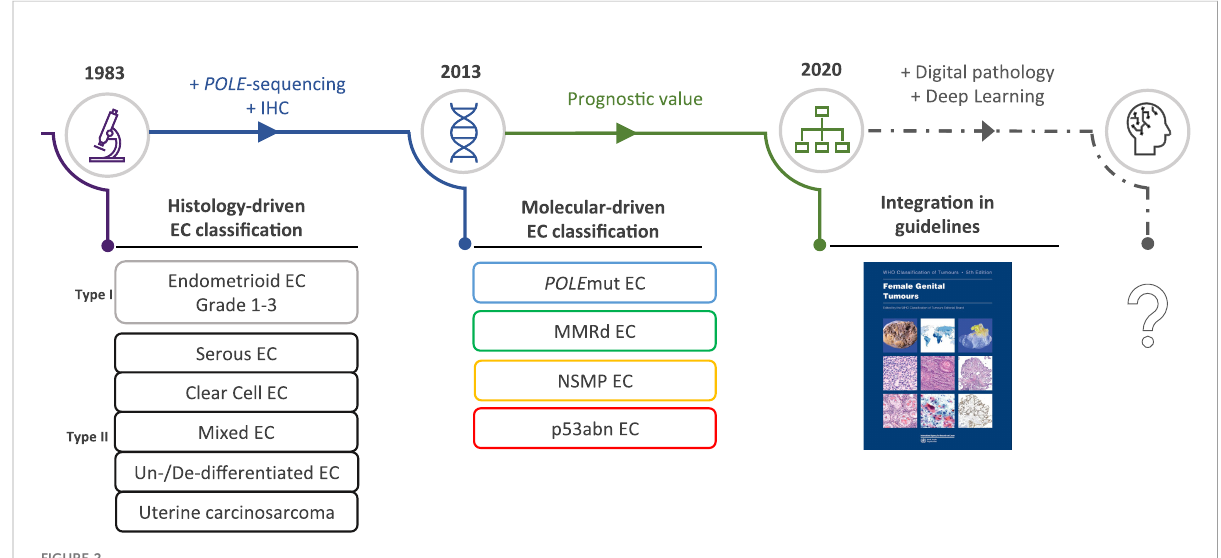
FIGURE 2 The evolving role of morphology in endometrial cancer diagnostics. EC, endometrial cancer; POLE mut, polymerase epsilon mutated; MMRd, mismatch repair de fi cient; NSMP, no speci fi c molecular pro fi le; p53abn, p53